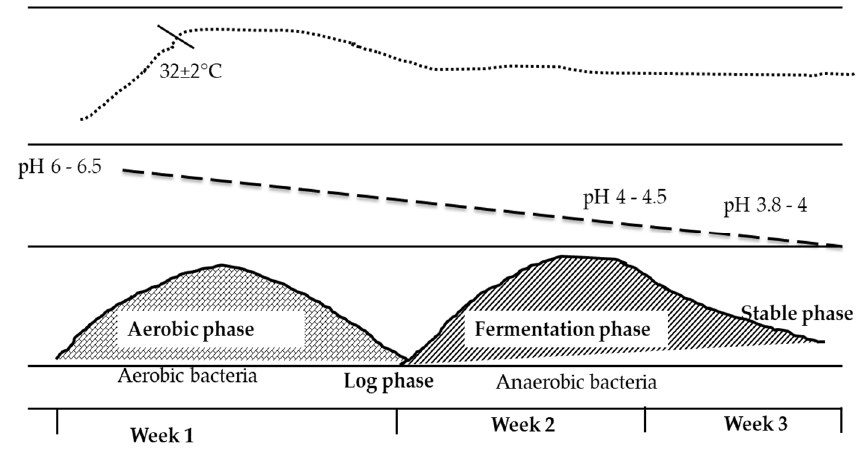
Figure 3. Phases of silage fermentation at ensiled plant materials.